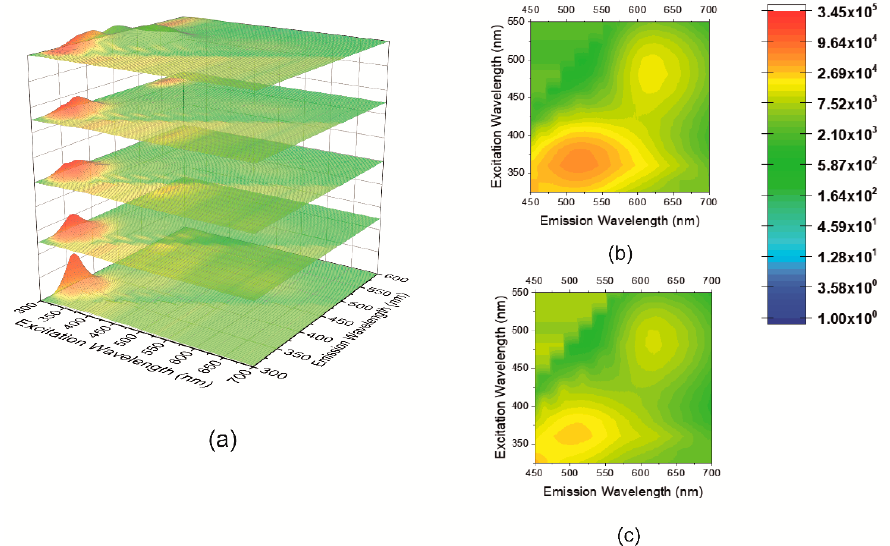
Figure 4. ( a ) 2D fluorescence surface color map of kinetic samples for U-PPD at reaction times of 2, 4, 6, 8 and 16 h (from bottom to top), 2D contour color map of U-PPD16 ( b ) and U-PPD8 ( c ) highlighting the third ( λ exc3 = 360 nm, λ em3 = 516 nm) and the fourth ( λ exc4 = 480 nm, λ em4 = 618 nm) emission center.